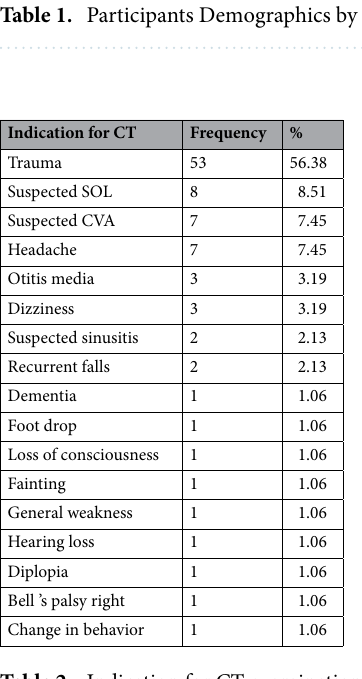
Table 2. Indication for CT examination in all patients. SOL Space Occupying Lesion, CVA Cerebrovascular accident.